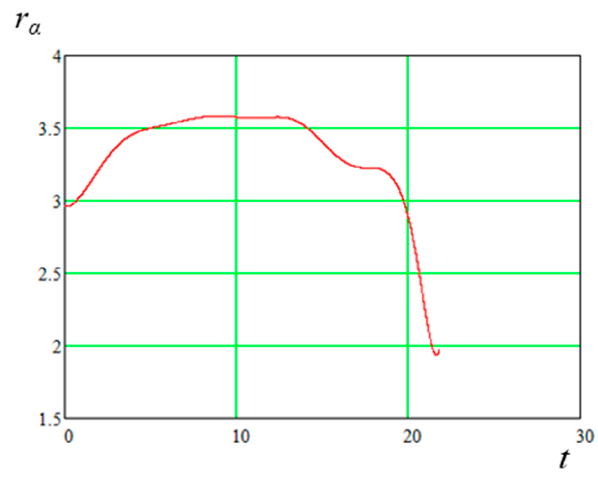
Figure 7. Dependence of the apogee radius [undim.] of the osculating SC orbit as a function of flight time [undim.].